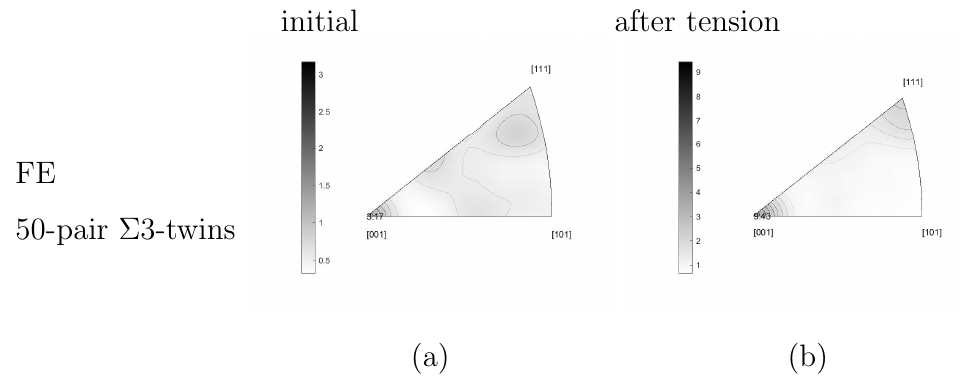
Fig. 14: Standard inverse pole figures for the selected 50 pairs of Σ3-twins in Fig. 12 : measured initial Figure 14. Standard inverse pole figures for the selected 50 pairs of Σ 3-twins in Figure 12: ( a ) Mea- sured initial texture after hot extrusion and before tension; ( b ) FE predicted textures after texture after hot extrusion and before tension (left); FE predicted textures after tension (right).